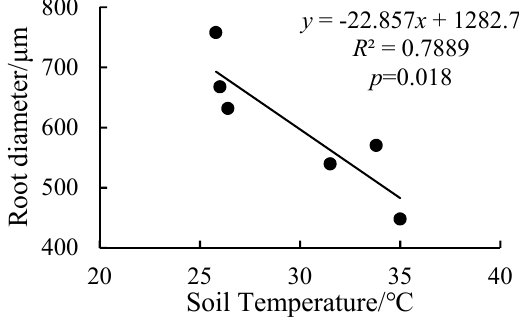
Figure 7. Linear regression between soil temperature and root diameter.